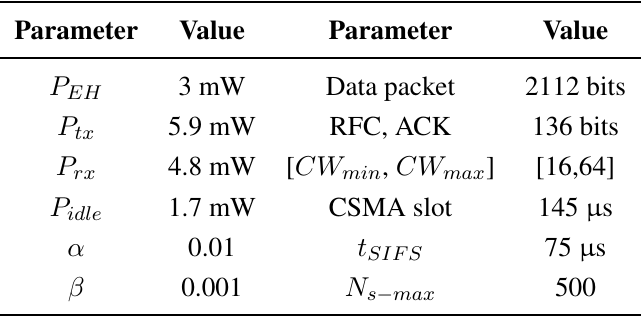
Table 1. Simulation parameters. RFC, request for